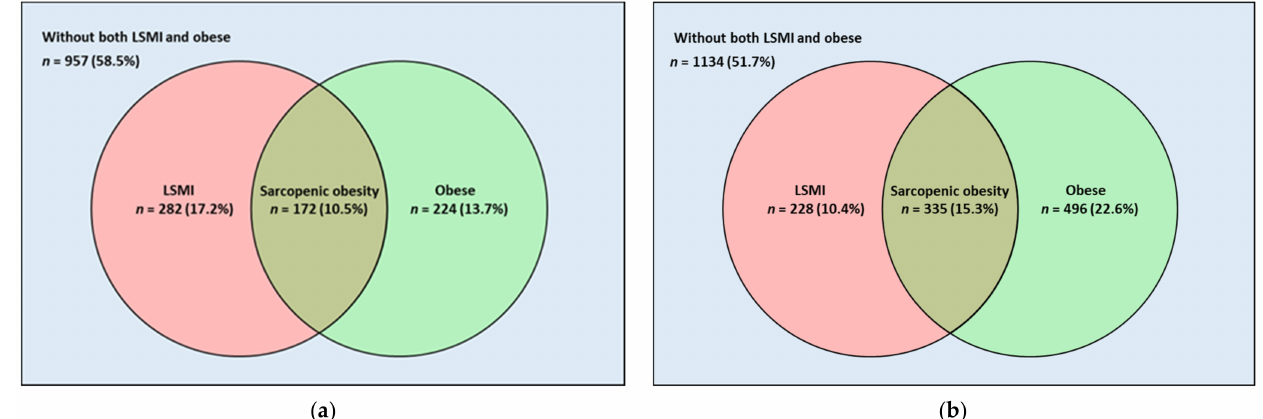
Figure 2. Venn Diagram showing the number of participants with LSMI, obesity, and sarcopenic obesity in ( a ) men and ( b ) women. LSMI was defined as appendicular skeletal muscle mass divided by body mass index <0.789 for men and <0.512 for women. Body mass index ≥ 25 kg/m 2 was considered obese. Sarcopenic obesity was defined as concomitant LSMI and obesity. Abbreviation: LSMI, low skeletal muscle mass